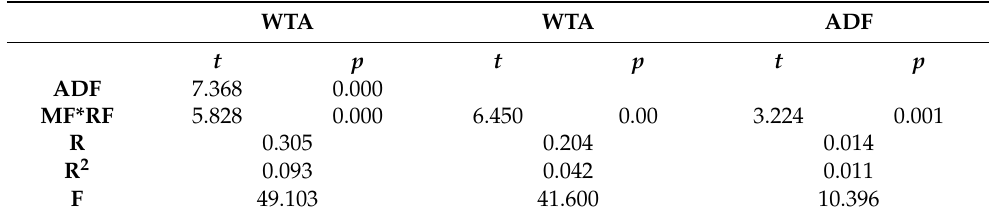
Table A2. Results of the mediating effect